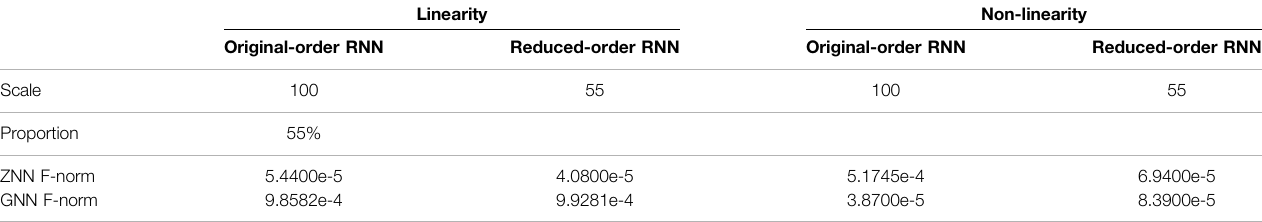
TABLE 4 | Comparison of the original-order RNN and the reduced-order RNN under Example 3.